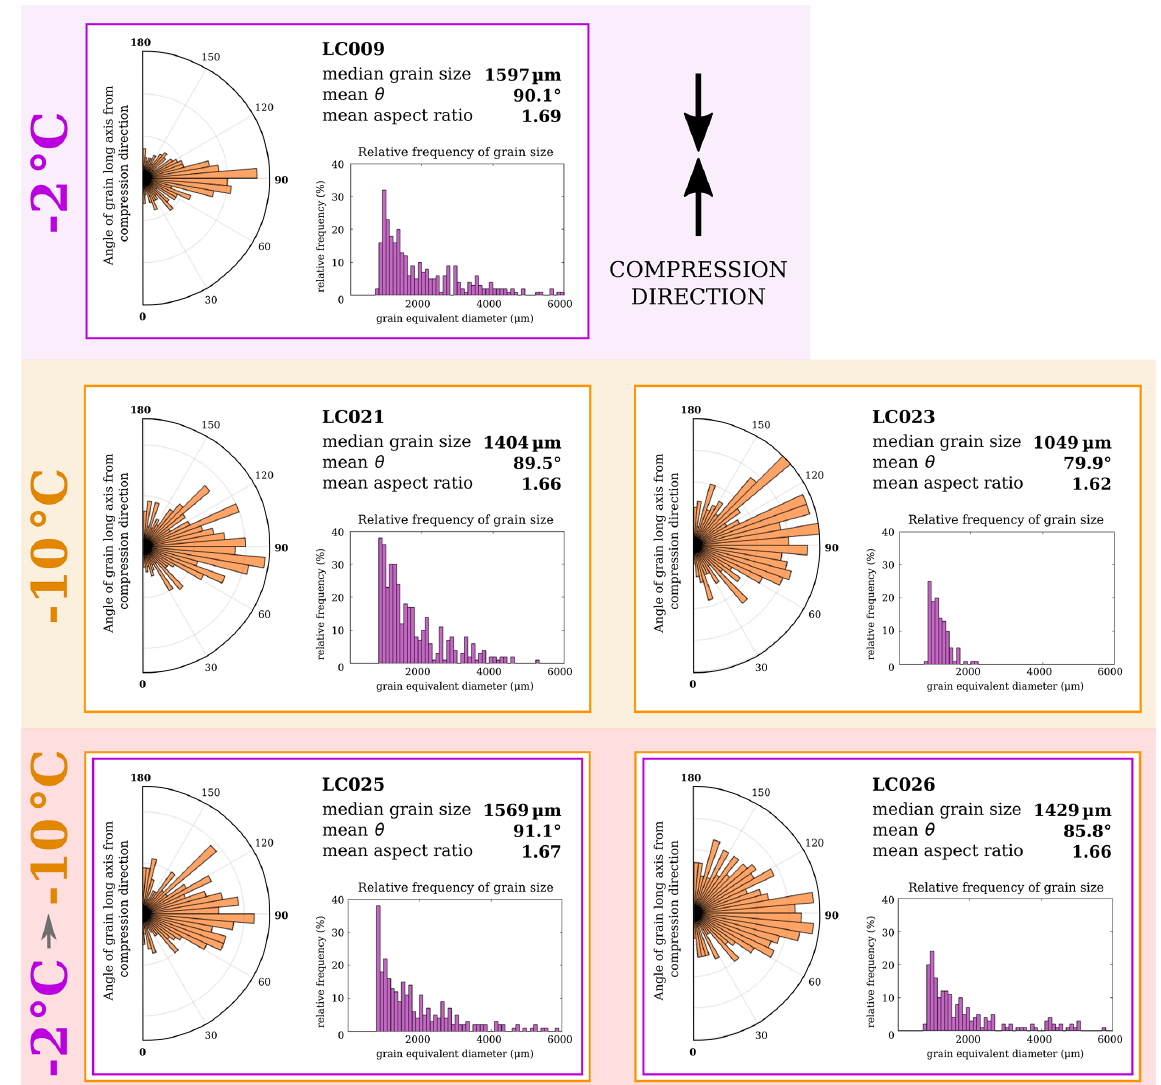
Figure B2. Polar histogram of grain orientations (angle of grain long axis from compression direction), histograms of grain size distribution (measured as grain equivalent diameter), and median values for all samples in set